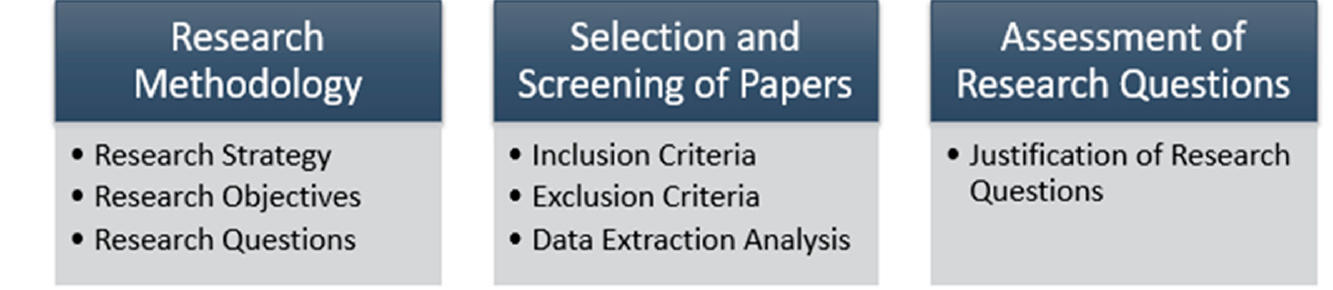
Figure 1. SLR Process Representation.